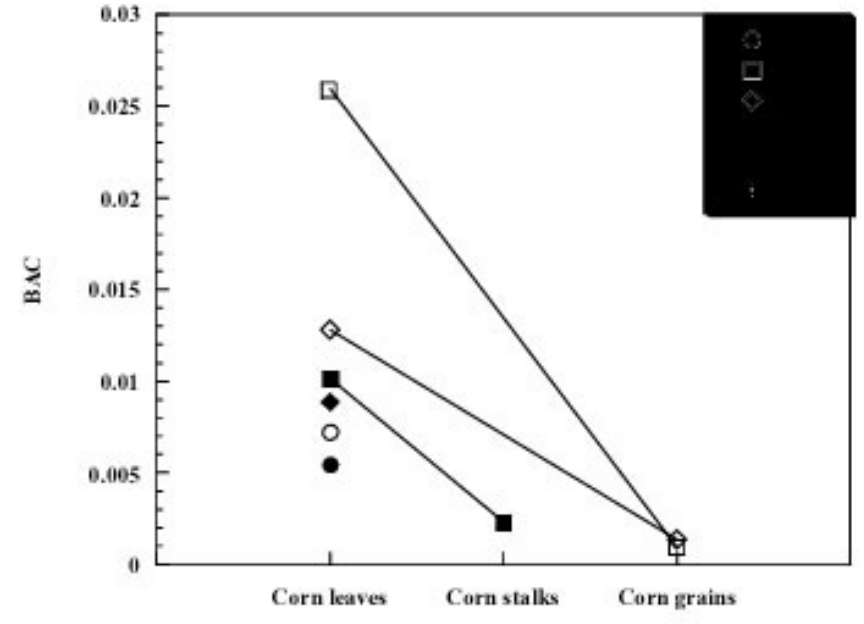
FIGURE 5 . Biological absorption coefficient (BAC = Cp/Cs) of corn leaves, stalks, and grains from the study areas.